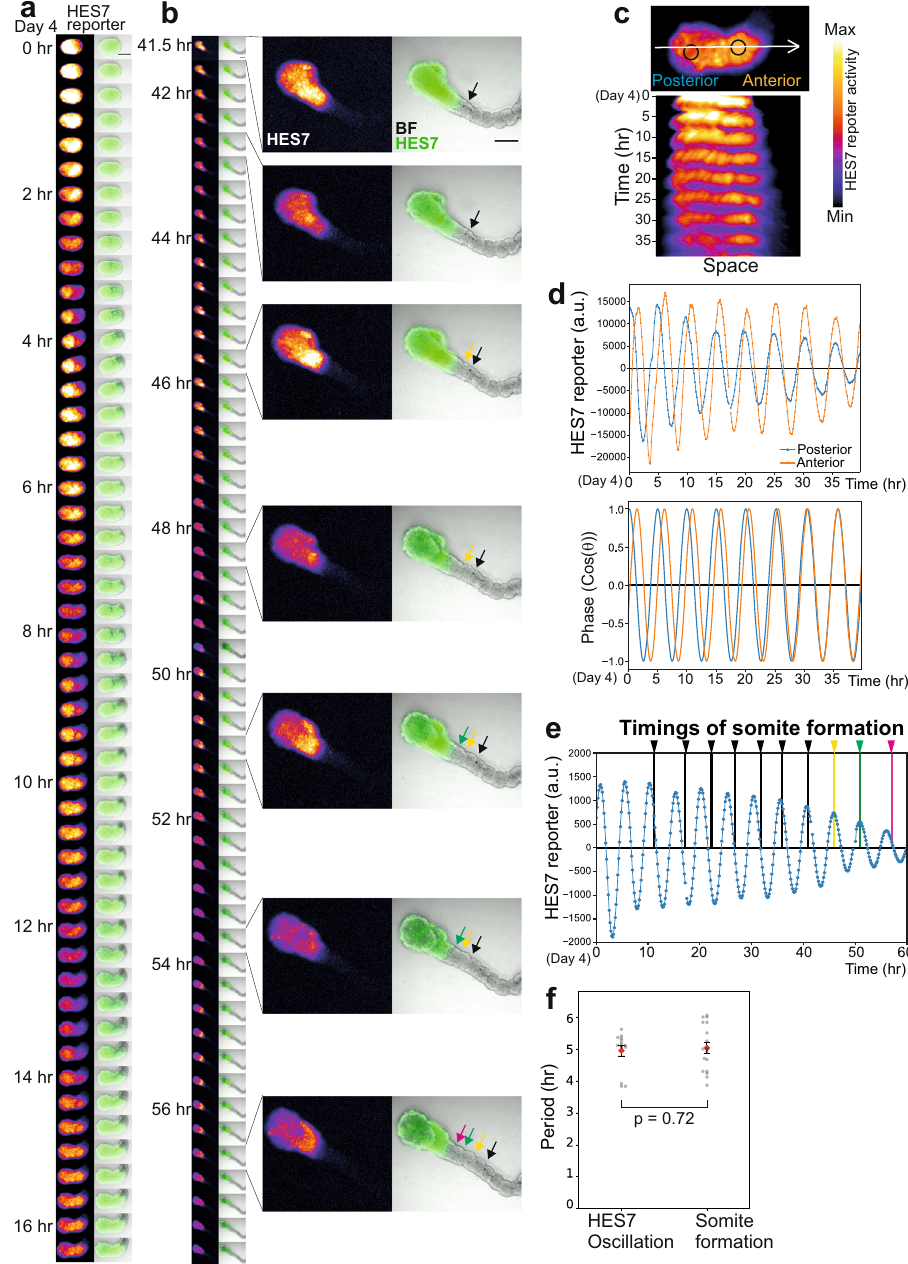
Fig. 3 Somites are formed according to the segmentation clock. a, b Time-lapse images of the HES7 promoter-luciferase reporter activity in a representative somitoid. The starting point on day 4 was de fi ned as time 0. See also Supplementary Movie 4. Scale bars: 500 µ m. Images were taken by an LV200 luminescent microscope. b Enlarged images of several time points are also shown. Arrows indicate the somite boundaries. BF: Bright fi eld. c Kymograph of the HES7 reporter activity measured along the posterior-anterior axis (the white arrow) of the same sample shown in a , b . d Detrended intensity (top) and the oscillation phase (bottom) of the HES7 reporter activity in the same sample shown in a , b . Blue and orange lines indicate the signals measured in the posterior and anterior regions of somitoids, respectively, marked in c . The gaps in the graph correspond to short halts of imaging to adjust the sample position. N = 14 samples showed similar oscillatory patterns. e Relationship between HES7 oscillations and segmentation timings. Detrended HES7 reporter activity of the entire image of the same sample shown in a and b. Arrows indicate the timings of somite formation, and the colors correspond to the arrows in b . f Periods calculated from the HES7 oscillations and somite formation. Mean ± SEM. Each point in the graph indicates an average period of several oscillation peaks or somite formation timings in one sample from day 5 to day 6. N = 14 (HES7 oscillation) and 17 (Somite formation). 5 independent experiments. P -value is from two-sided student ’ s t-test. Source data are provided as a Source Data fi